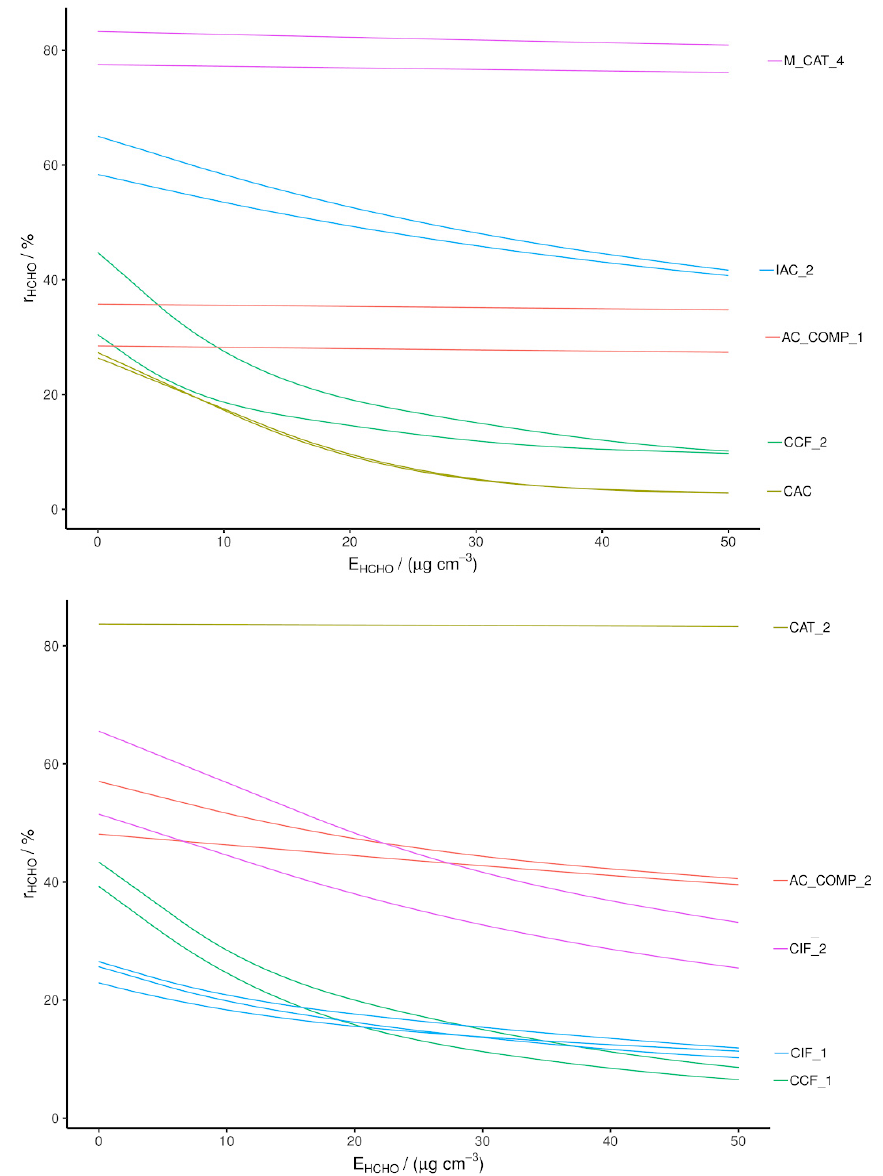
Figure 2. Single-pass HCHO removal e ffi ciency measured with a CRDS, separated into two plots for ease of Figure 2. Single ‐ pass HCHO removal efficiency measured with a CRDS, separated into two plots for ease of viewing.